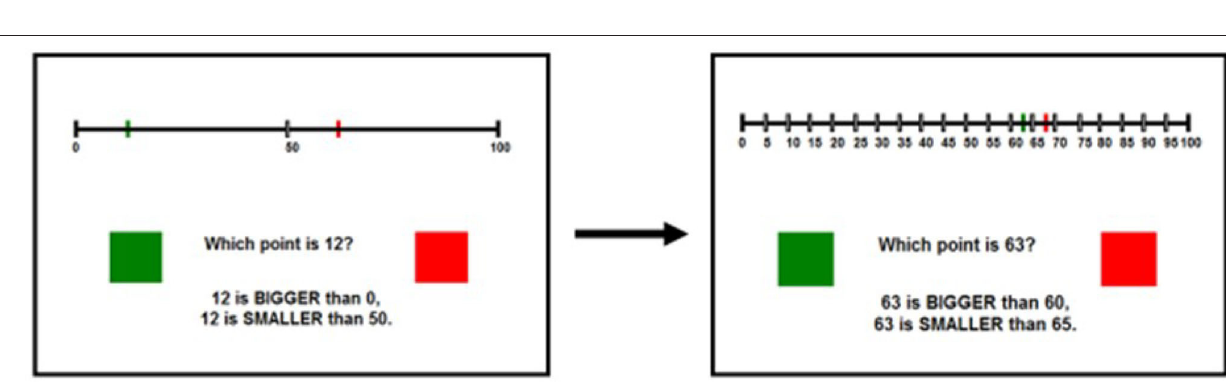
Frontiers in Psychology |